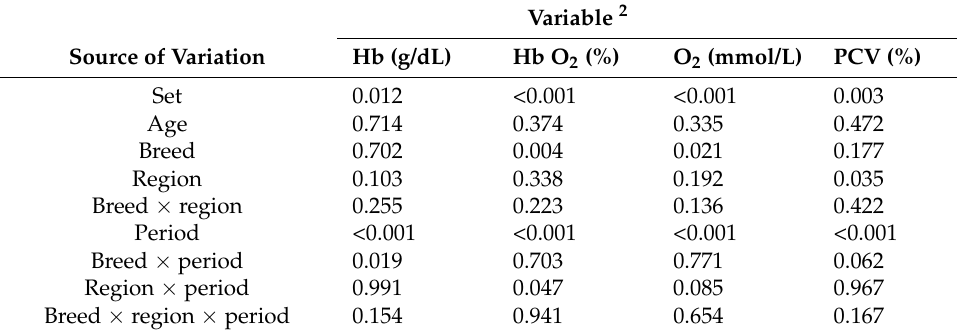
Table 2. p values for effects of region, breed, and period with different heat load indexes on hemoglobin concentration and oxygen saturation, blood oxygen concentration, and packed cell volume (PCV) in hair sheep based on samples collected at the end of the week 2 of each of the four 2 weeks periods 1 . Variable 2 Source of Variation Hb (g/dL) Hb O 2 (%) O 2 (mmol/L) PCV (%) Set 0.012 <0.001 <0.001